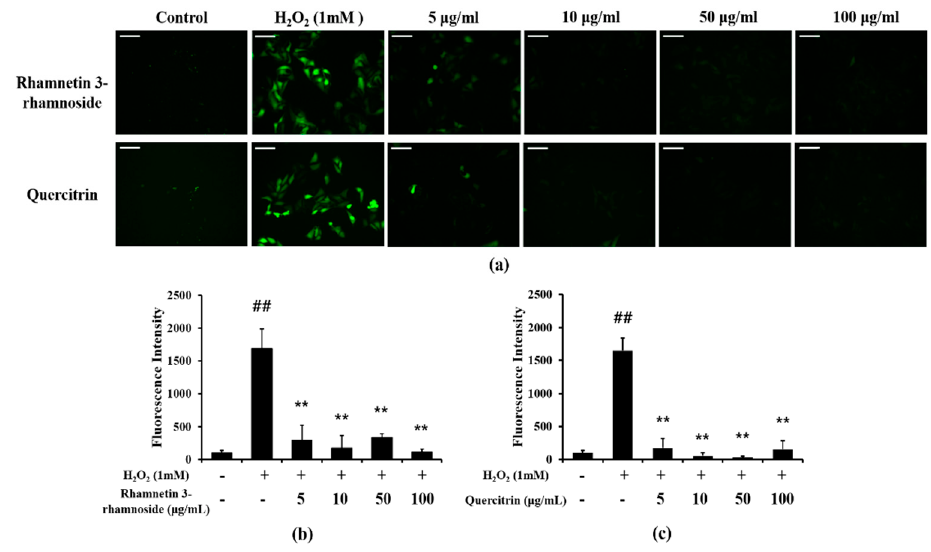
Figure 7. Effects of rhamnetin 3-ramnoside and quercitrin on ROS production. ( a ) representative figure of DCFDA stained HeLa cells, ( b ) quantitative analysis of ROS production in rhamnetin 3-rhamnoside-treated cells, ( c ) quantitative analysis of ROS production in quercitrin-treated cells. rhamnetin 3-ramnoside and quercitrin-treated cells exhibited marked reduction in ROS production induced by H 2 O 2 treatment. This experiment was performed in triplicate. Scale bar = 50 μ m. Data shown as the mean ± SD. ## , vs. Control, p < 0.01, **, vs. H 2 O 2 -treated cells, p < 0.01.